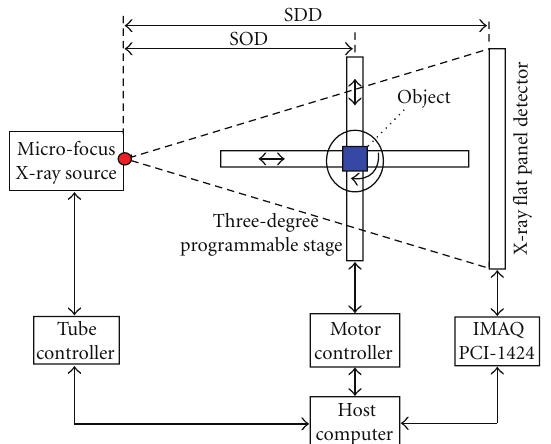
Figure 1: Schematic diagram of the micro-CT system. It consists of a microfocus X-ray source, a flat panel X-ray detector and a three- degree programmable stage. All of them are mounted on an optical bench and controlled by a host